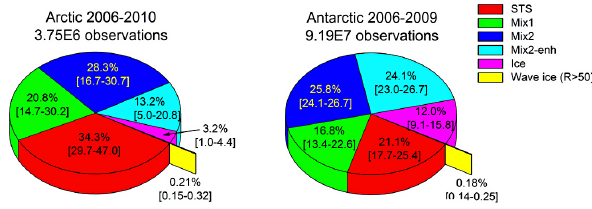
Fig. 3. Composition breakdown of PSCs observed by CALIPSO in the Arctic and Antarctic during 2006–2010. The percentages are averages over four seasons in each hemisphere, and the minimum and maximum percentages in any one season are indicated by the numbers in brackets.